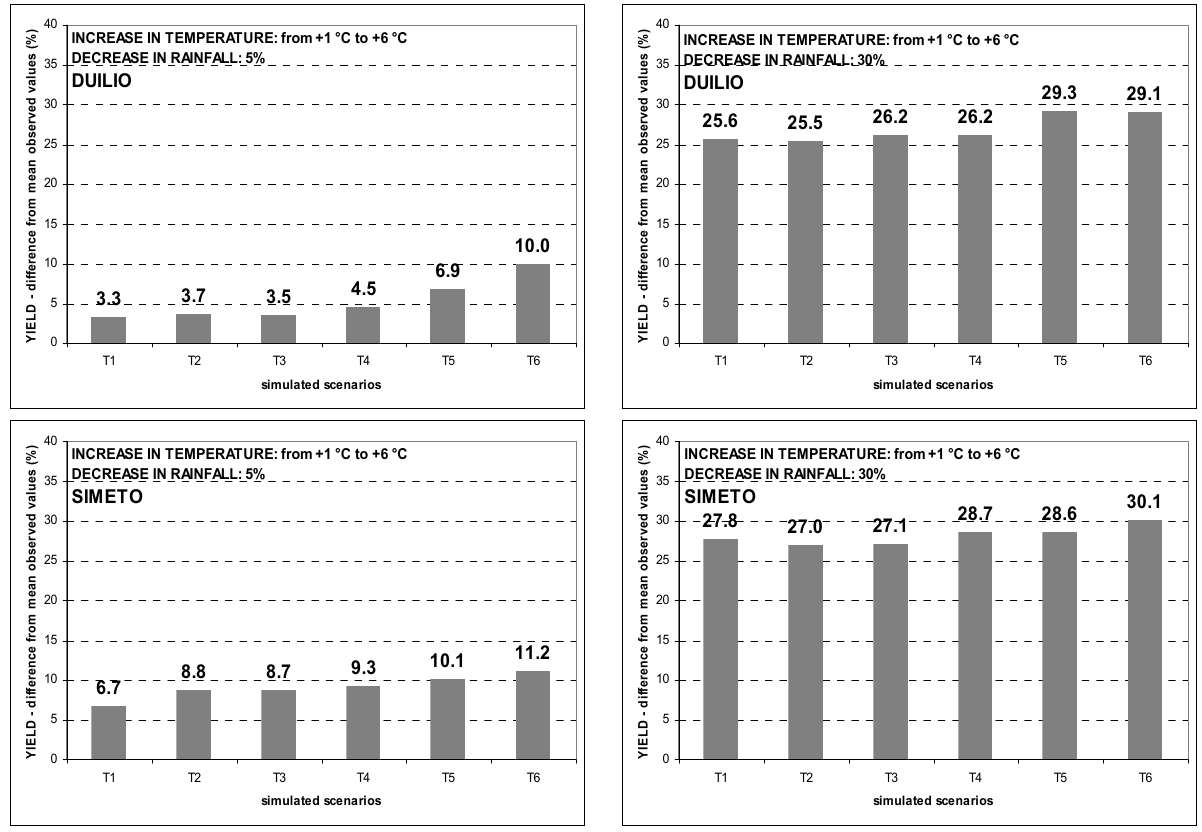
Figure 5. Percentage decline of grain yield over the period 1989–2004 at the experimental site of Ussana for climate change scenarios characterized by increasing temperature (from +1 °C to +6 °C) and rainfall reduction by 5% ( A ) and 30% ( B ).